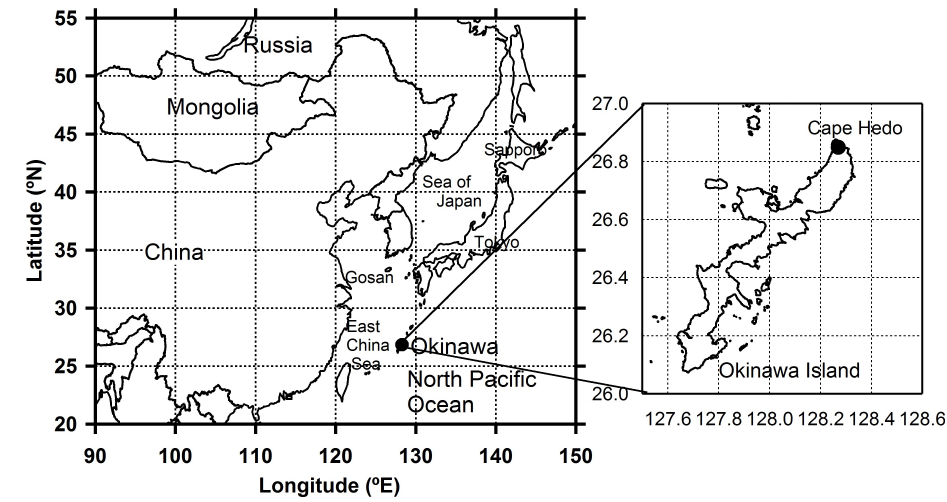
Fig. 1. Map showing the geographical region of Cape Hedo, Okinawa, where sampling was